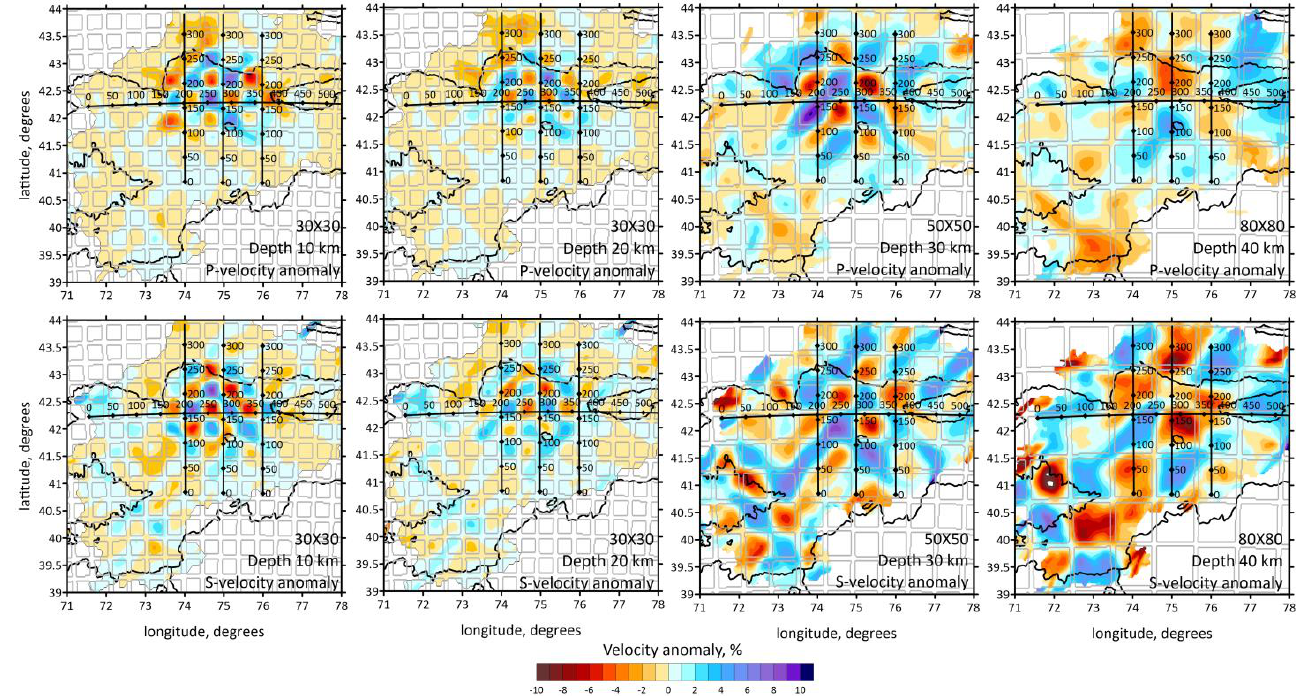
Figure 7. Checkerboard test with the anomalies 30 × 30, 30 × 30, 50 × 50 and 80 × 80 km.